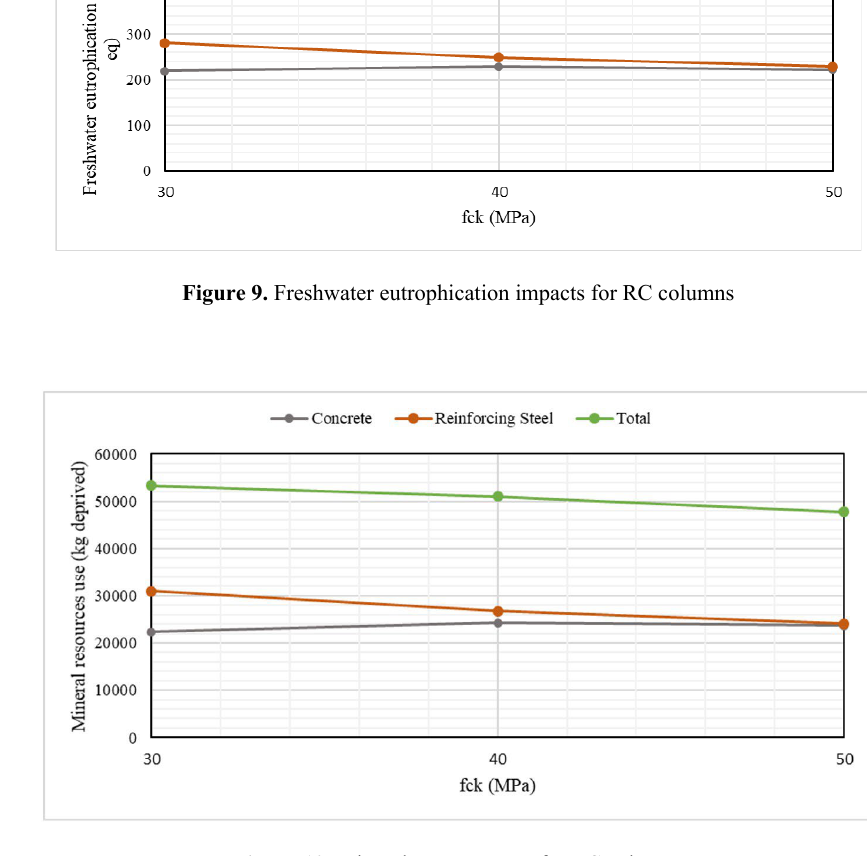
Figure 10. Mineral resources use for RC